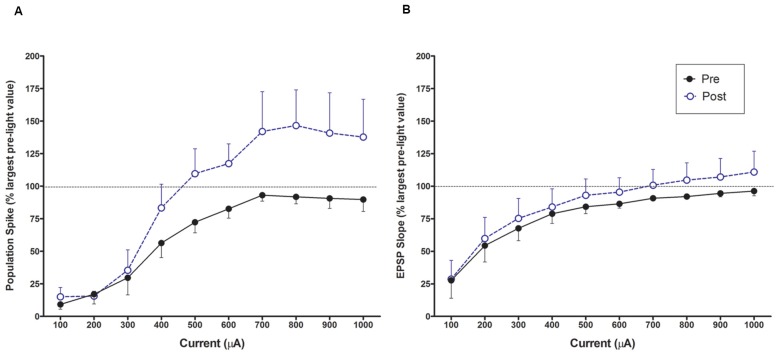
Input output curves for increasing perforant path currents prior to light activation LTP baseline and after the conclusion of the experiment. (A) A leftward shift for population spike occurs after the experiment for population spike amplitude once threshold is exceeded. (B) There is no change in EPSP slope input/output over the same period.